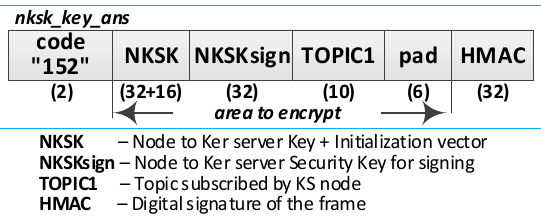
Figure 16. The confirmation frame for node registration.